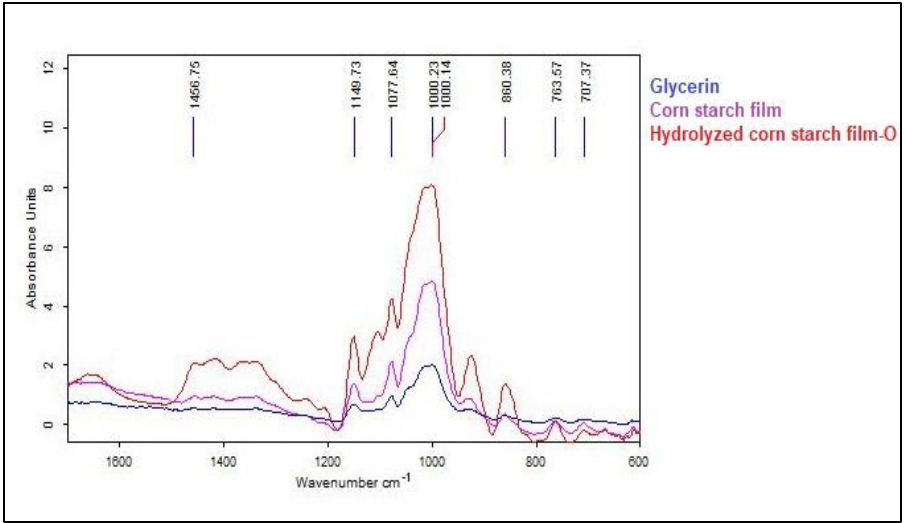
Figure 5. FTIR spectra of hydrolyzed corn starch (under optimum conditions) films samples and corn starch films.